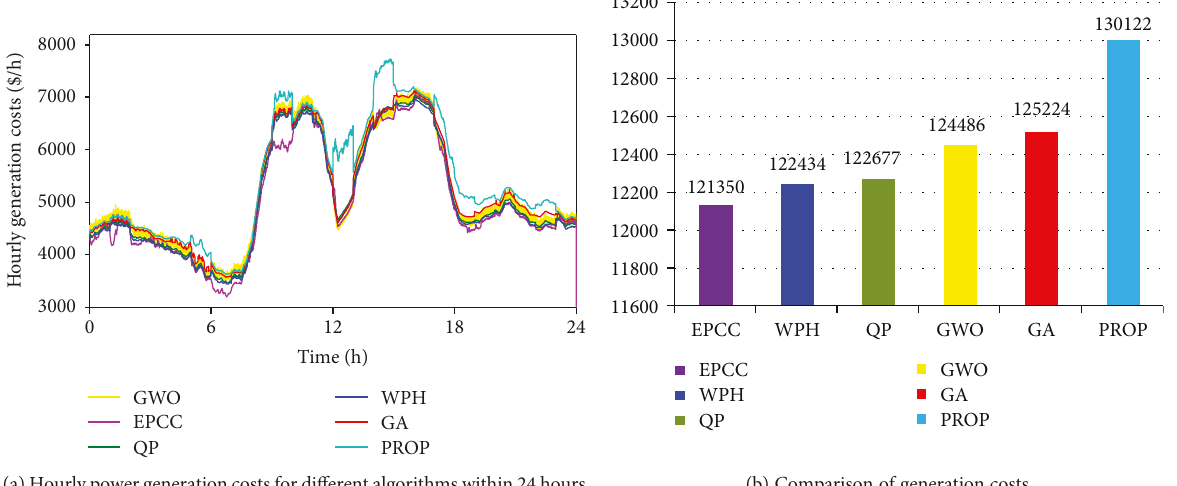
Figure 13: Comparison of the results of di ff erent